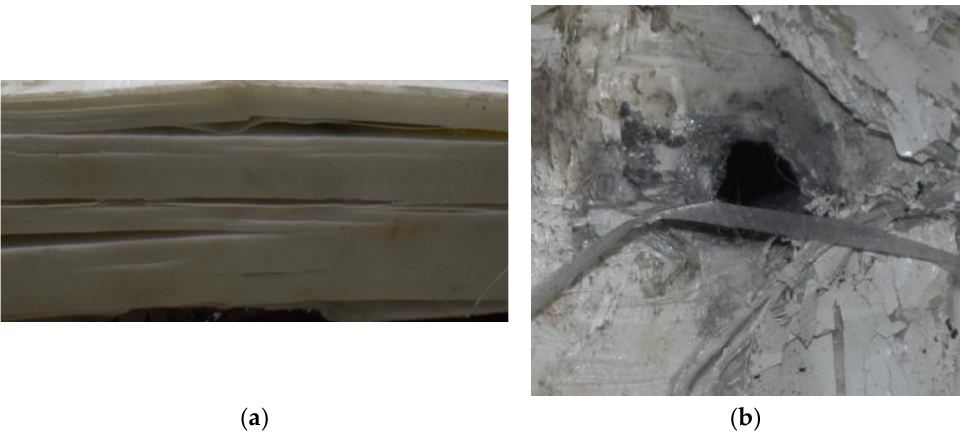
Figure 8. Failure states of the PE laminates. ( a ) Side view of PE laminates. ( b ) Outlet of PE laminate.